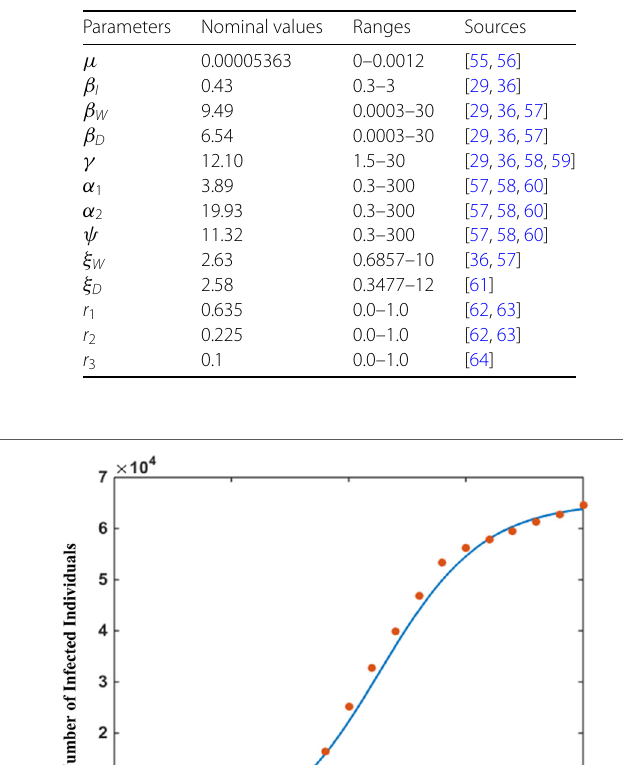
Table 3 Parameters values used in model (3.2)